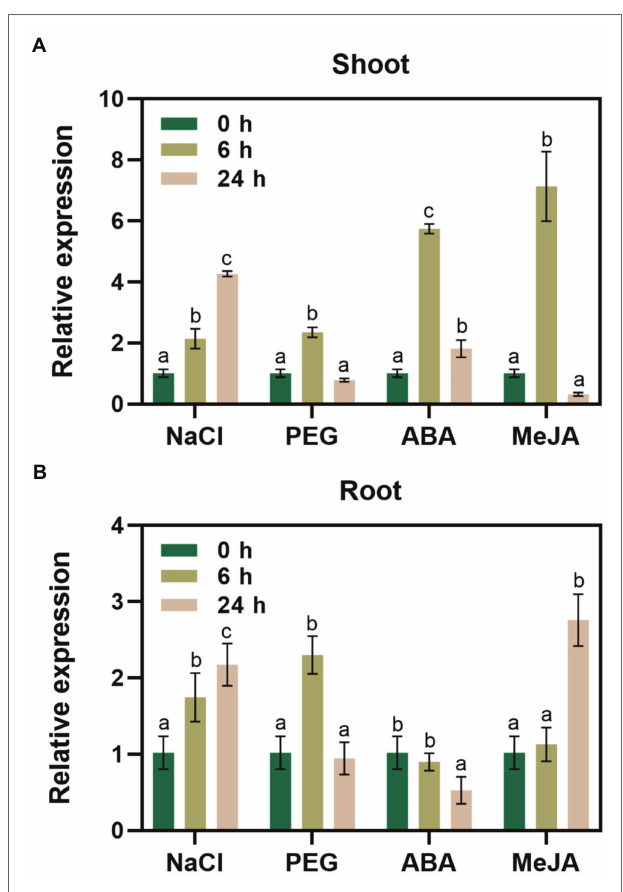
FIGURE 2 | Relative expression levels of GlNPC3 under different stress conditions. GlNPC3 expression levels in shoots (A) and roots (B) under different stress conditions. Glehnia littoralis seedlings were subjected to salt (200 mM NaCl), drought (20% PEG 6000), or hormone (100 μ M ABA or 100 μ M MeJA) treatments for 0, 6, or 24 h. The shoots and roots of G. littoralis were harvested at the indicated time intervals for RNA extraction. GlCYP2 was used as the internal control. Data represent means three biological replicates with three pooled plants each ± SD (three technical replicates per biological replicate). Different letters indicate statistically significant difference in each treatment ( p < 0.05, Duncan’s multiple range